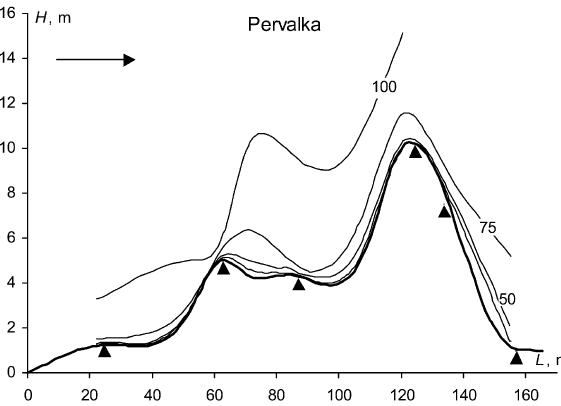
Fig. 7. Variations in wind speed (%) in the cross-shore profile near Juodkrant ė